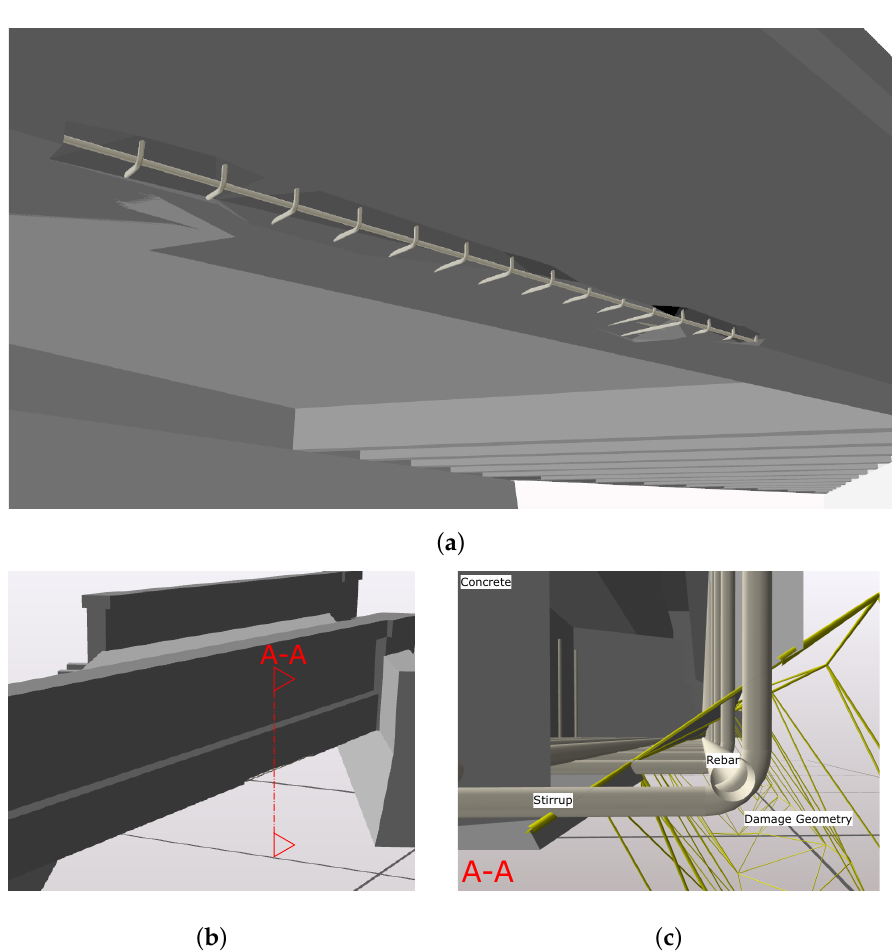
Figure 14. Close-up view of the modeled defect. ( a ) close-up view of the bridge beam with spalling subtraction and exposed reinforcement ( b ) bridge overview with marked section A-A ( c ) section A-A with the subtraction as wireframe.